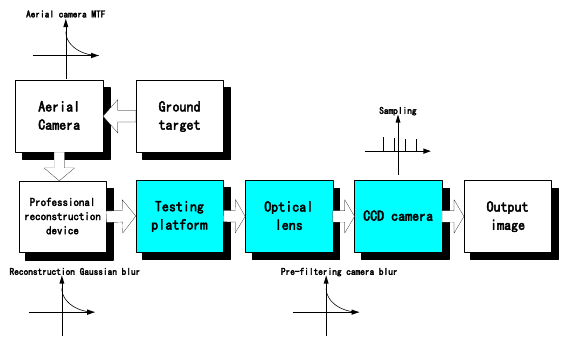
Figure 2. Diagram of analogous scene imaging